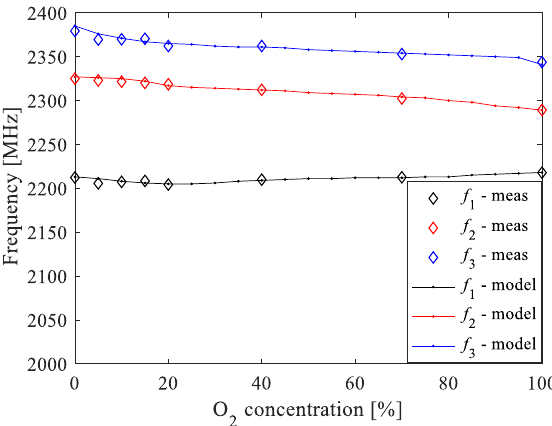
Figure 14. Comparison of the resonant frequencies determined by using the measured Y 11 and the corresponding simulations based on the proposed ANN model.